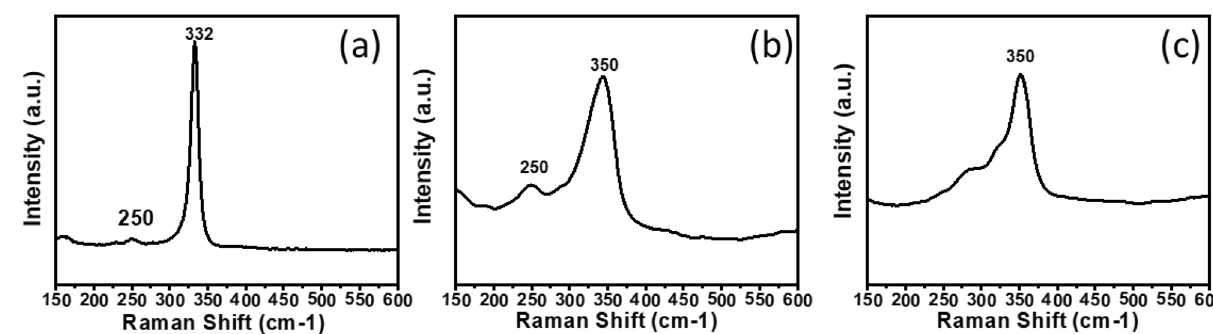
Figure 5. Raman spectra of the particulate Cu 2x Sb 2(1−x) S y systems where x = ( a ) 0.4, ( b ) 0.6 and ( c ) 0.8. Indicating the presence of chalostibite (CuSbS 2 ) and tetrahedrite (Cu 12 Sb 4 S 13 ),